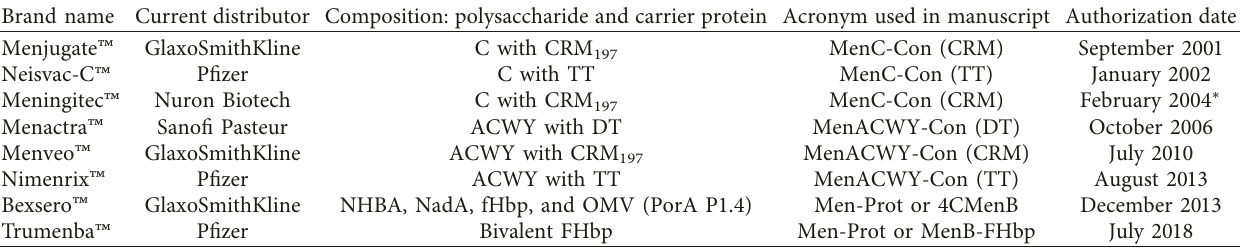
Table 1: Meningococcal conjugate and protein vaccines authorized for marketing and sale in Canada. Brand name Current distributor Composition: polysaccharide and carrier protein Acronym used in manuscript Authorization